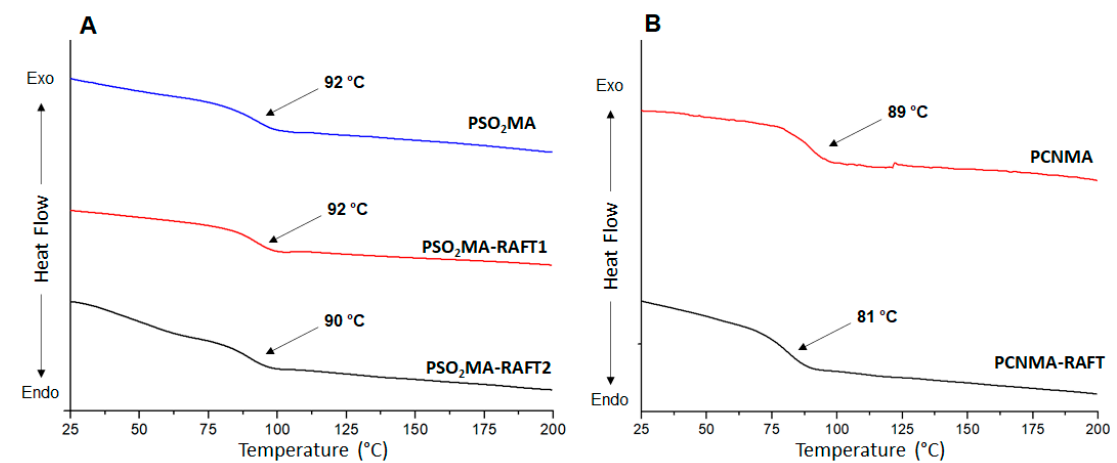
Figure 5. DSC analysis of polymethacrylates containing sulfonyl ( A ) and nitrile ( B ) groups. T g values are indicated by black arrows.